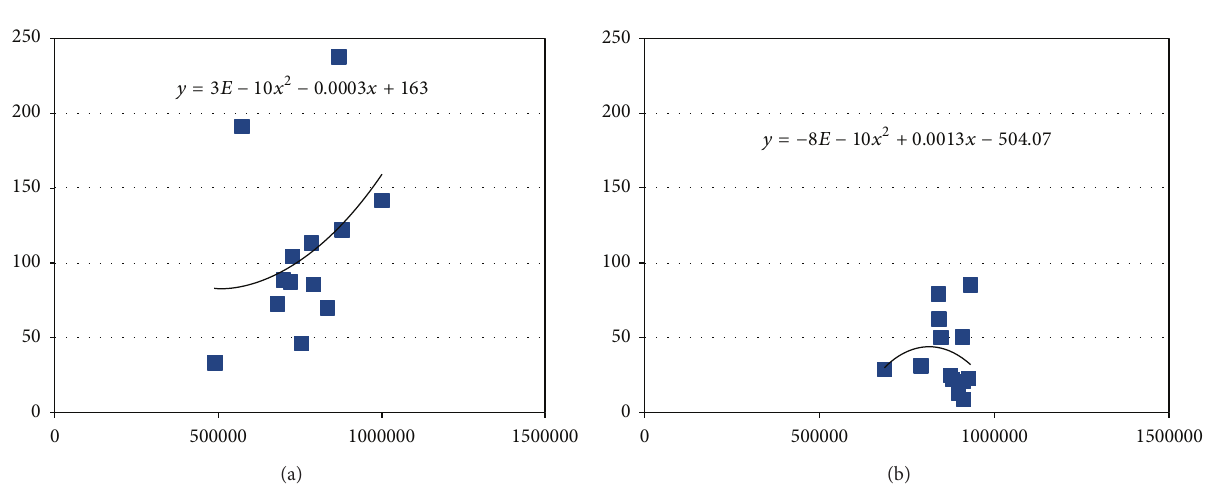
Figure 3: Correlation between the contrast ( 𝐷 value) in the 𝑦 -axis and the area over the peripapillary ring threshold (pixels) in the 𝑥 -axis, for the Carl Zeiss (a) and the Topcon camera